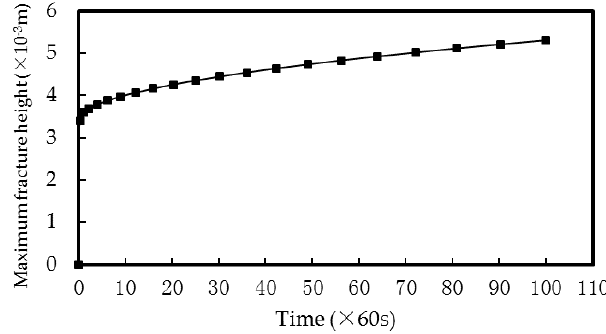
Figure 5. Relationship between maximum fracture height and time.